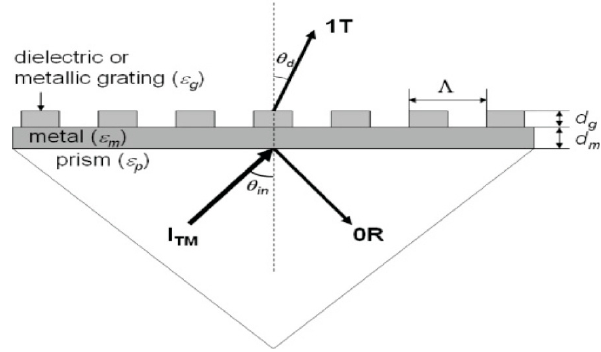
Figure 4. Grating coupling configuration of a SPR sensor with angular modulation. The thin metal layer deposited onto prism has a thickness d m . The metallic or dielectric grating has a period Λ and a fill factor f. The diffracted wave is transmitted in a substrate environment (water or air) (reproduced from [45] with permission of OSA Publishing).